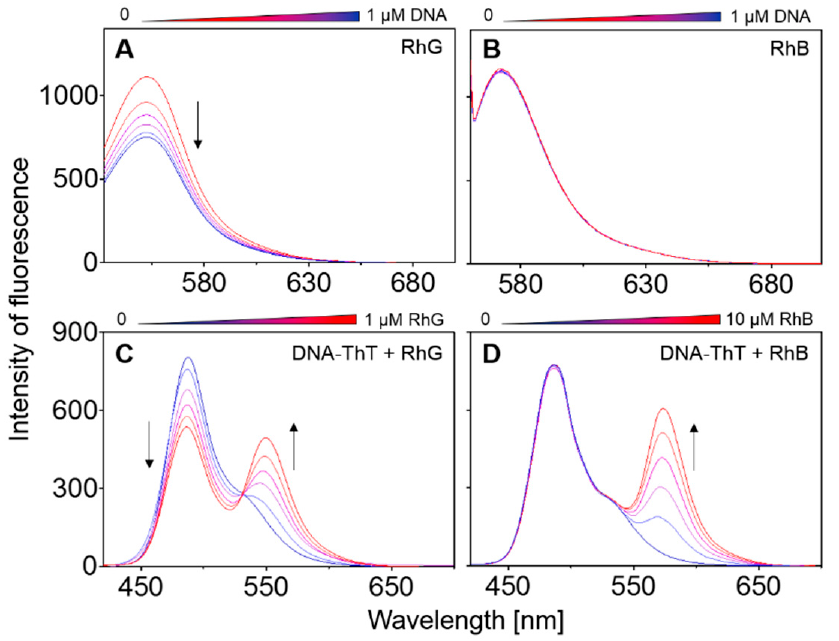
Figure 8. Fluorescence titration of 25 nM RhG ( A ) and RhB ( B ) with the stepwise addition of the G3T oligonucleotide (0, 0.2, 0.4, 0.6, 0.8 and 1.0 µ M) corresponding to 0 − 40 molar equivalents. Increasing concentrations of DNA are highlighted with arrows. Measurements were performed in a mRB buffer supplemented with 50 mM KCl at a pH of 7.0; excitation of RhG and RhB at 527 nm and 555 nM, respectively, the excitation and emission slits were 2.5 nm (5 nm in B) and the scan speed was 240 nm/min. 1 µ M G4-ThT mixture (1: 1 molar eqv.) titrated with 0–1 µ M RhG ( C ) and 0–10 µ M RhB ( D ), the excitation was at 413 nm.